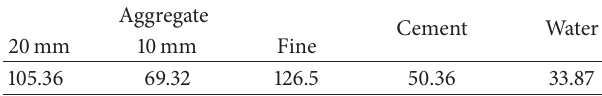
Table 2: Required batch quantities for the 90 cylinders (in kg).